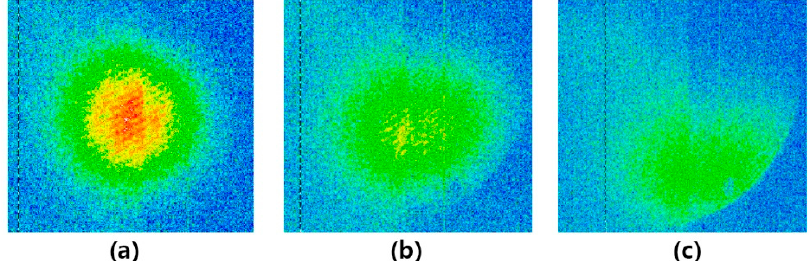
Figure 2. Changes in scattered light spots caused by thermal distortion . ( a ) Irradiation begins ( b ) Start to deform ( c ) Body explode.